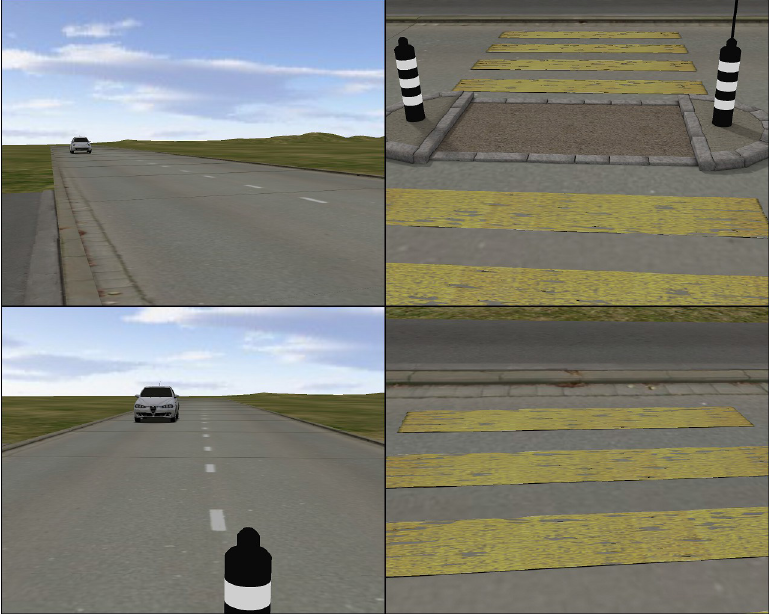
Fig 1. The participants ’ perspective standing on the pavement (top) and on the centre island (bottom)